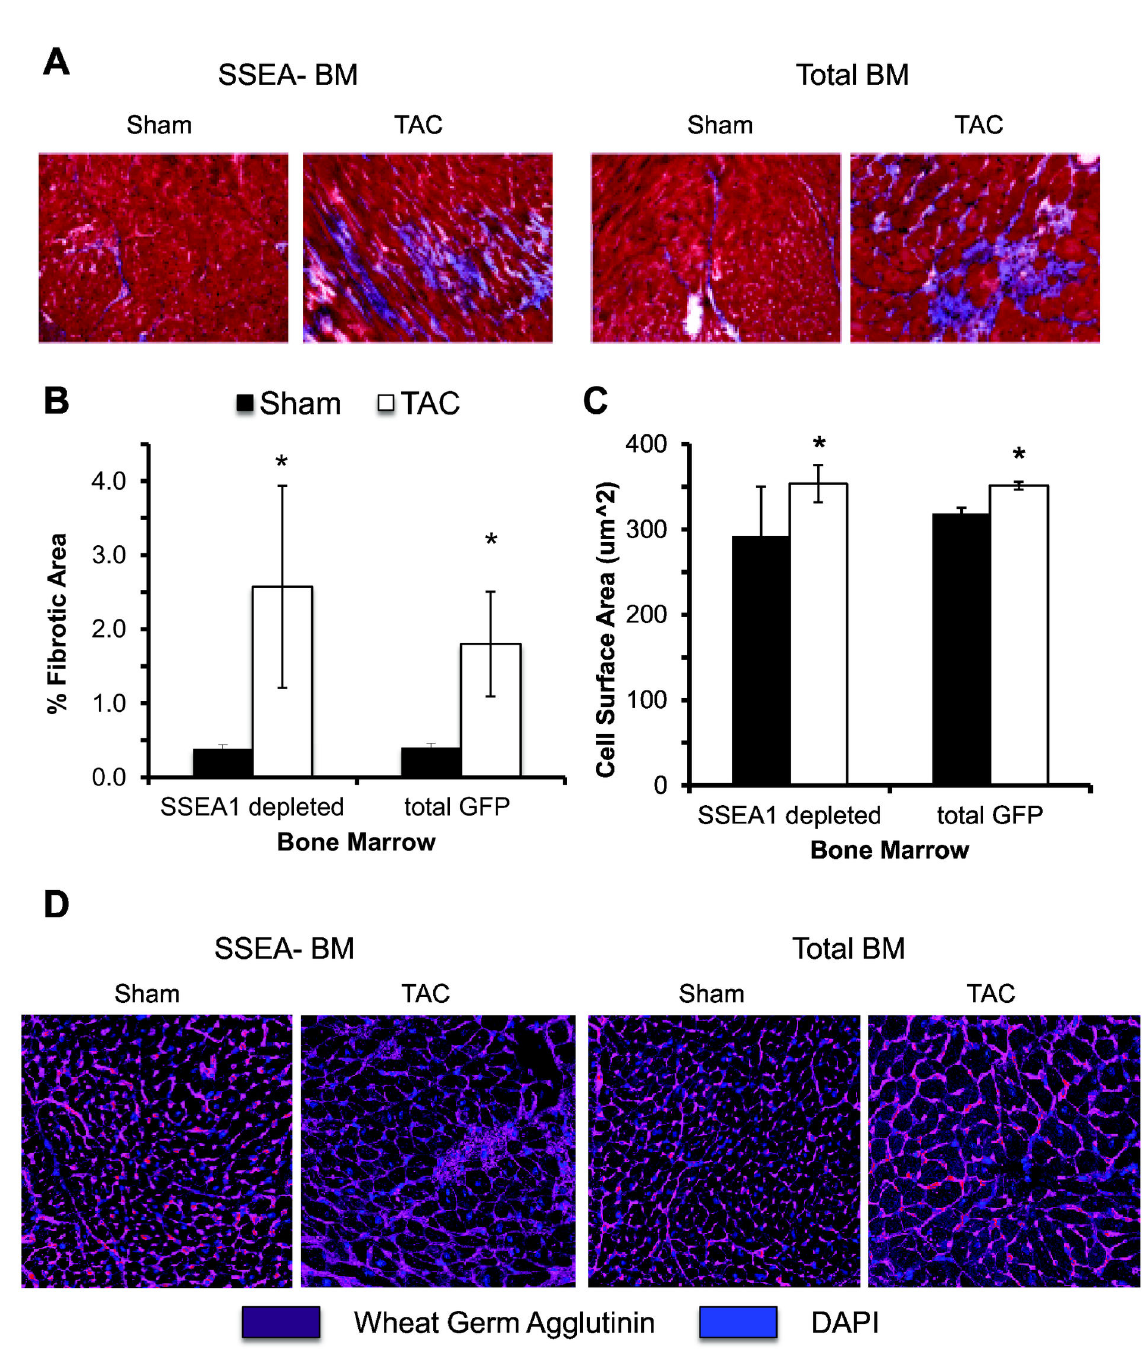
Figure 3. TAC increases fibrosis and myocyte surface area. (A) Mason’s trichrome staining for collagen (Magnification 20x). (B) TAC (white bars) significantly increased the presence of fibrosis in the hearts compared to sham (black bars) but no difference was observed based on bone marrow. (C) Four weeks after TAC, mice had increased myocyte hypertrophy compared to sham though no differences were determined between bone marrow. (D) Representative immunofluorescence of transversely sectioned myocytes of TAC and sham groups four weeks after surgery (40x Magnification). Myocyte membranes are outlined by WGA (purple) and nuclei are labeled with DAPI (blue). n = 4-6. * P ≤ 0.05 compared to sham. Abbreviations: TAC, trans-aortic constriction; WGA, wheat germ agglutinin; SSEA1, stage-specific embryonic antigen 1; SSEA1-BM. SSEA1+ cell depleted bone marrow; BM, bone marrow; GFP, green fluorescent protein. doi: 10.1371/journal.pone.0068528.g003 PLOS ONE |